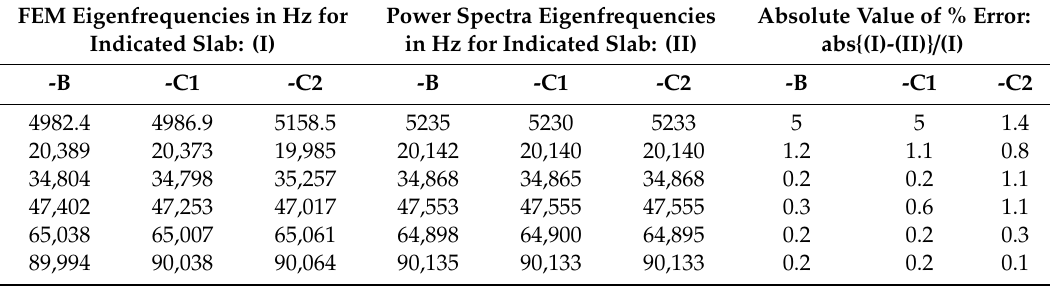
Table 1. Eigenfrequencies of type-B, -C1 and -C2 slabs as determined by the solution of the finite elements model compared with the ones picked up in signal power spectra.